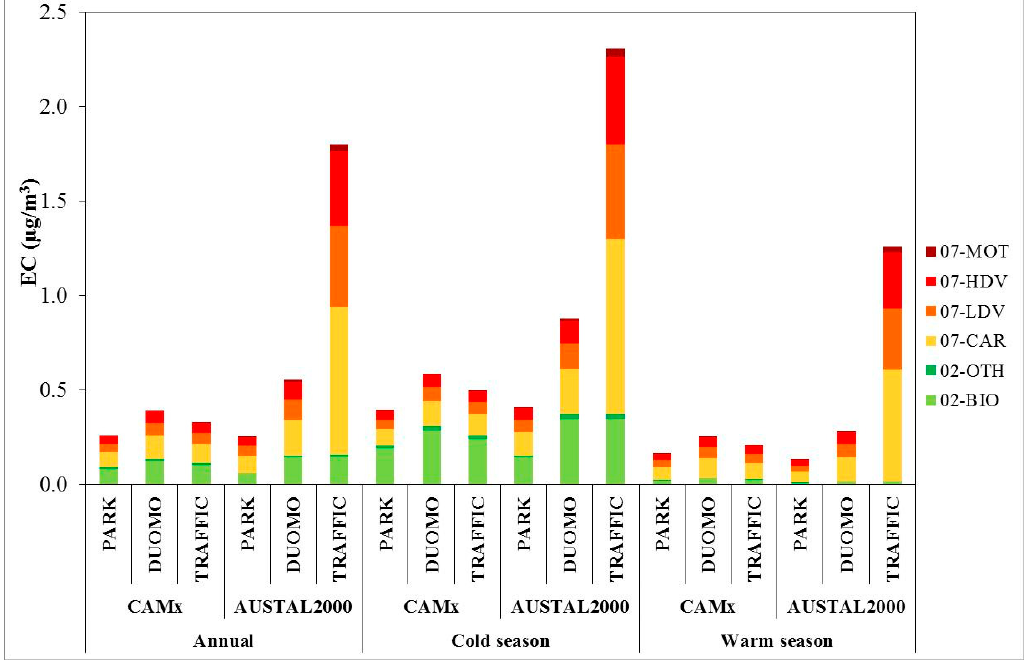
Figure 6. EC levels and source apportionment comparison between CAMx and AUSTAL2000 at the urban receptors (PARK, DUOMO, TRAFFIC) for LOCAL region emissions.